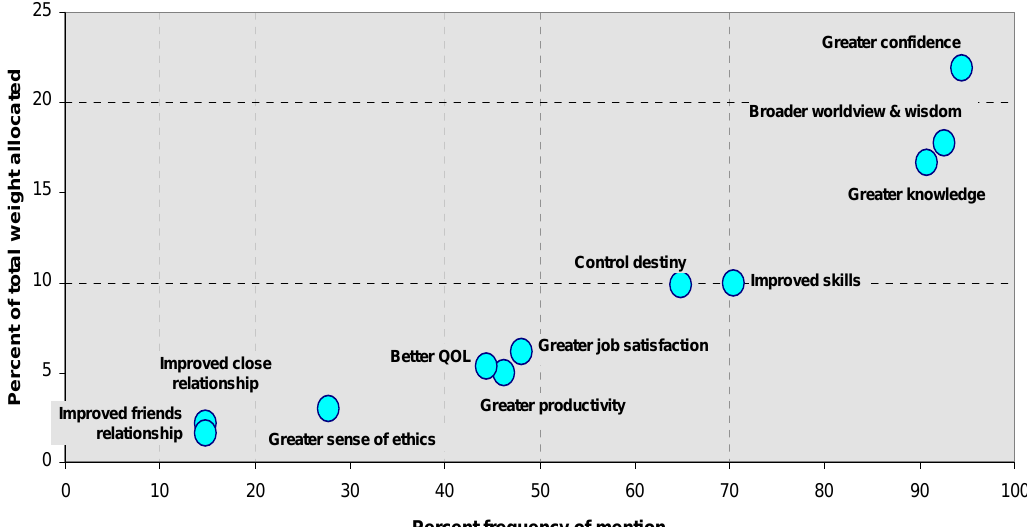
Figure 7: The perceived non-financial benefits of an